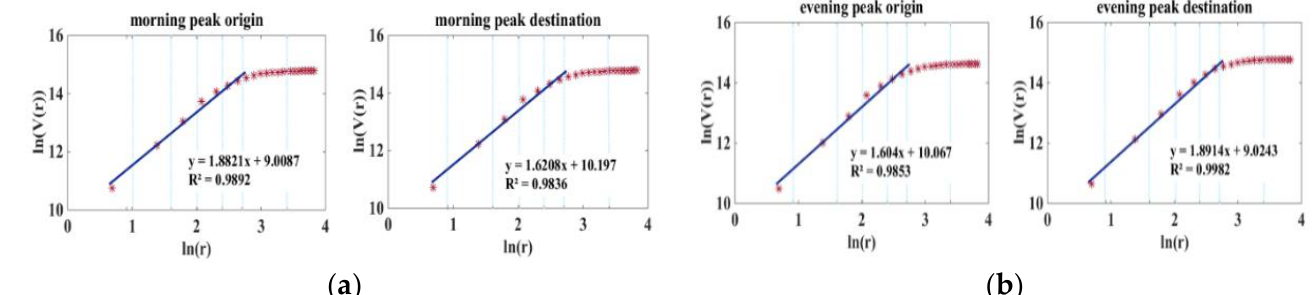
Figure 16. Volume dimension of BSS demand.